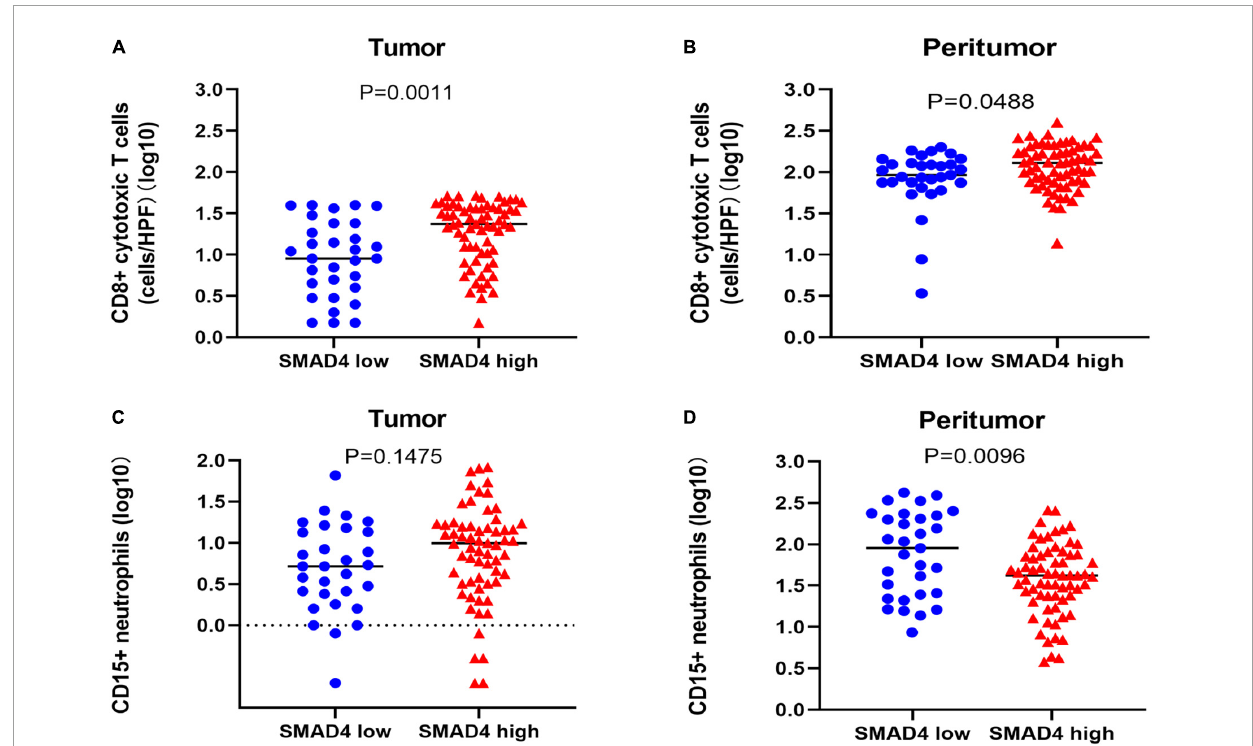
FIGURE5 Correlation between SMAD4 status and CD8 + cytotoxic T cell and CD15 + neutrophil counts in HPC. SMAD4 expression level proportionally correlated with CD8 + cytotoxic T cell counts in tumor (A) and peritumor (B) tissues. SMAD4 expression level was inversely related to CD15 + neutrophils in peritumor areas (D) but not in tumor areas (C) . HPC, hypopharyngeal carcinoma.